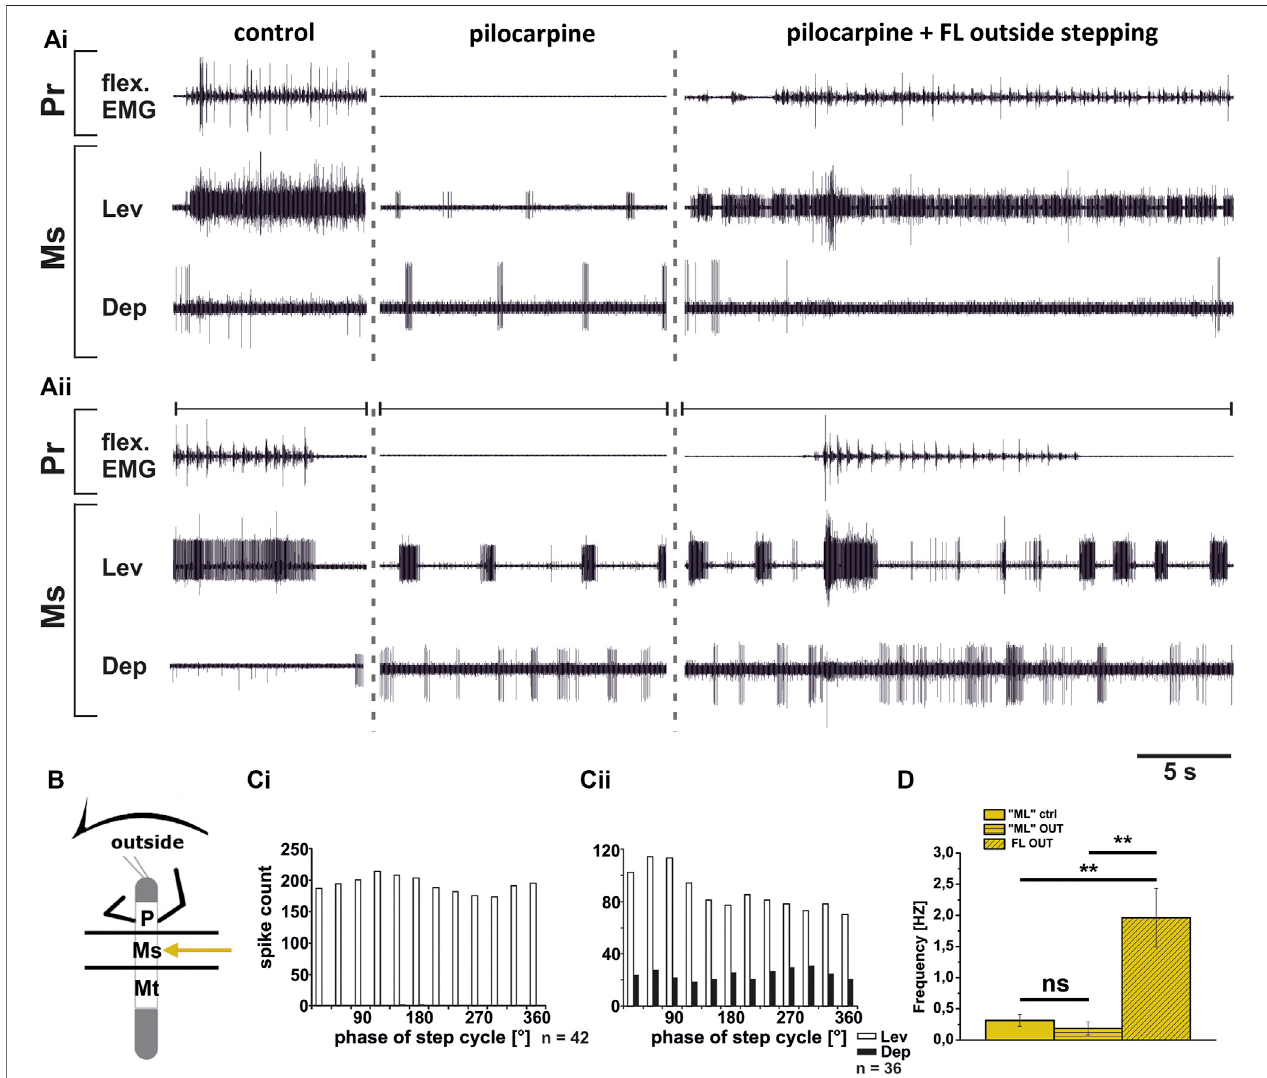
FIGURE 9 | Motor output of levator (Lev) and depressor (Dep) trochanteris MN pools in the pilocarpine activated deafferented mesothoracic ganglion (Ms) during front leg (FL) outside stepping; (Ai,Aii) two examples for FL Flexor EMG ( “ fl ex ” , top), together with extracellular recordings of the ipsilateral mesothoracic levator (C1 nerve,secondtrace)anddepressor(C2nerve,thirdtrace)nerveduringcontroloutsidesteps,inpilocarpinew/oFLsteps,andduringoutsidesteppingunderpilocarpine application; (B) . Schematic of experimental split-bath con fi guration; (Ci,Cii) . Phase histograms of levator and depressor nerve activity under pilocarpine during outside stepping from the animals in (Ai,Aii) , with respect to the FL step cycle; (D) . Comparison of pilocarpine C1 control Burst frequency ( “ ML ” ctrl) with deafferent ML- segment C1 burst frequency ( “ ML ” OUT) during inside steps of the front legs (FL OUT) from 25 walking sequences in fi ve experiments (signi fi cance level < 0.01); n = number of analyzed steps. Pr: prothoracic/FL segment. ns: not signi fi cant. The sketch indicates a stick insect with front legs in a fl exed (inside) or stretched (outside) position, and the arrow above indicating the turning direction, the arrow on the side the recorded thoracic segment. The black bars symbolize the vaseline barrier.